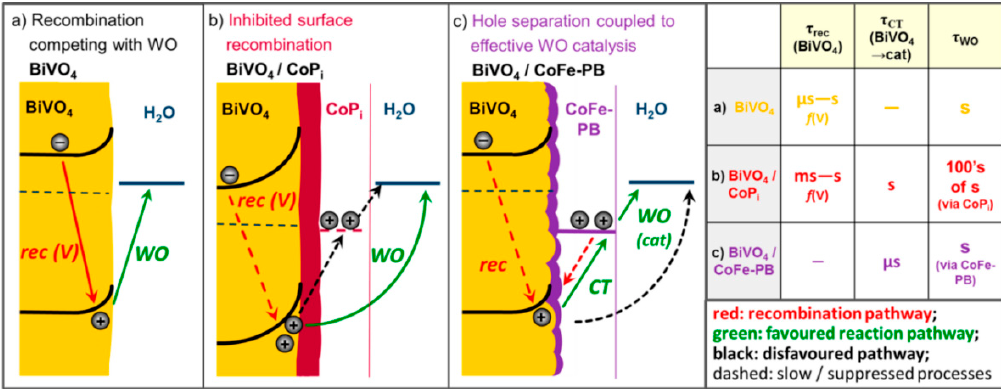
Figure 13. ( a ) Photon conversion efficiency in unmodified BiVO 4 is limited by the kinetic competition between potential dependent surface recombination (rec (V)) and WO; ( b ) CoPi modification reducing the applied potential needed to effectively suppress surface recombination, allowing holes to react via the BiVO 4 surface (Hole charge transfer (CT) to CoPi and WO via CoPi is slow and does not contribute to the photocurrent.); and ( c ) CoFe-PB enhancing the efficiency via a different mechanism. (Efficient hole CT to CoFe-PB separates holes from electrons in the BiVO 4 surface thereby suppressing this recombination pathway. This is coupled to effective water splitting catalysis.) The table on the right reveals the varied time required for the above three materials to participate in each stage ( τ rec = time for BiVO 4 electron–hole recombination time, τ CT = time for charge transfer from BiVO 4 to the co-catalyst, and τ WO = time for total water oxidation) of the water oxidation. WO on CoPi is 2 − 3 orders of magnitude slower than WO via the BiVO 4 surface or WO via CoFe-PB. This is mainly because the thick (100 nm) CoPi layer does not have the ability to catalyze directly, which prevents the holes in BiVO 4 from directly reacting with water. Copied with permission from [113]. Copyright © 2018 American Chemical Society.